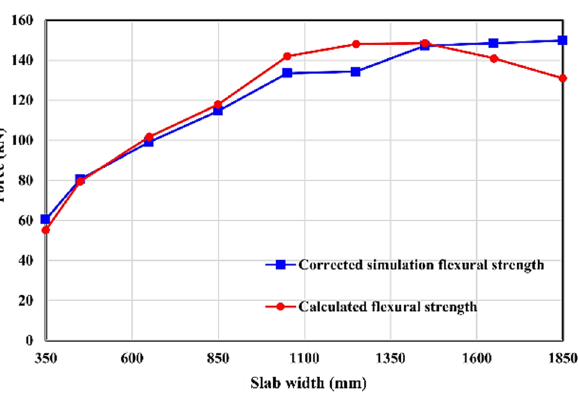
Figure 25. Simulation flexural strength versus calculated flexural strength for slab width models.